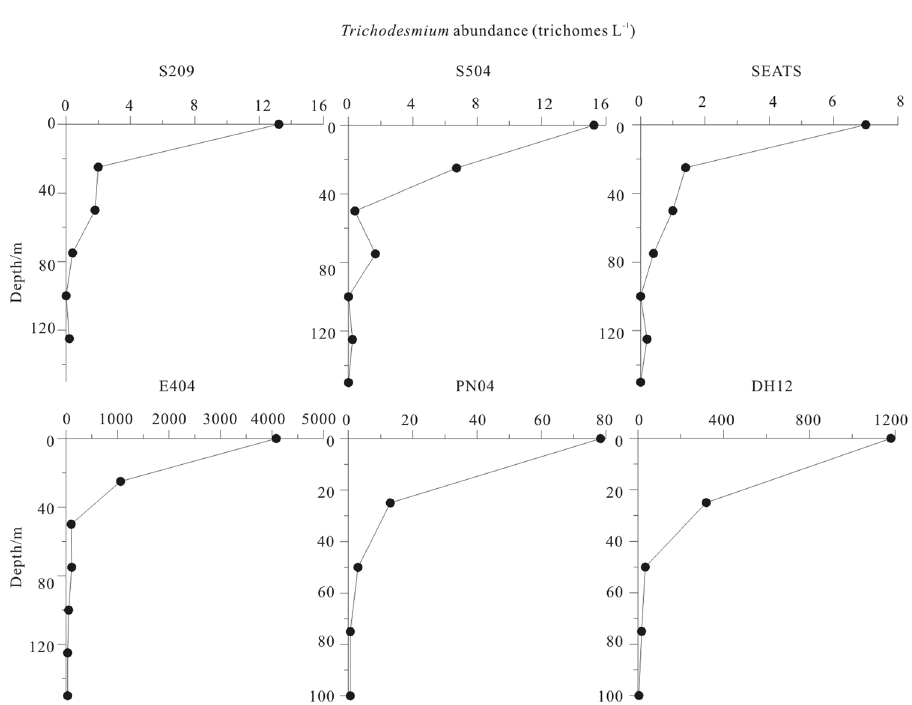
Figure 6. Vertical distribution of Trichodesmium . Note for software: Origin 8.5 PRO